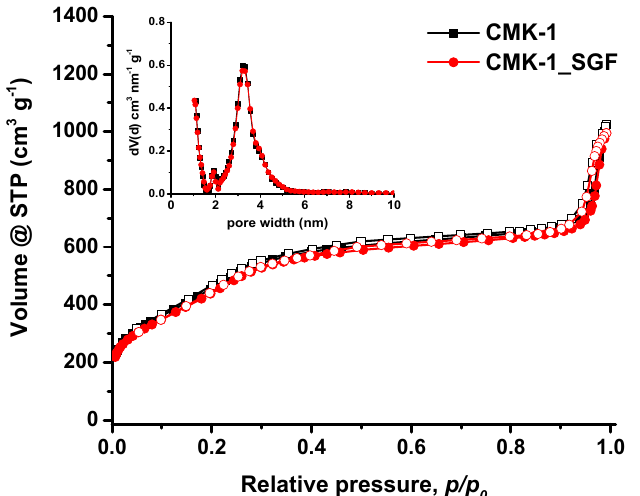
Figure 3. N 2 adsorption (full symbols)-desorption (open symbols) isotherm and pore size distribution (PSD) (inset) of the CMK-1 carbon spheres before and after incubation with SGF.